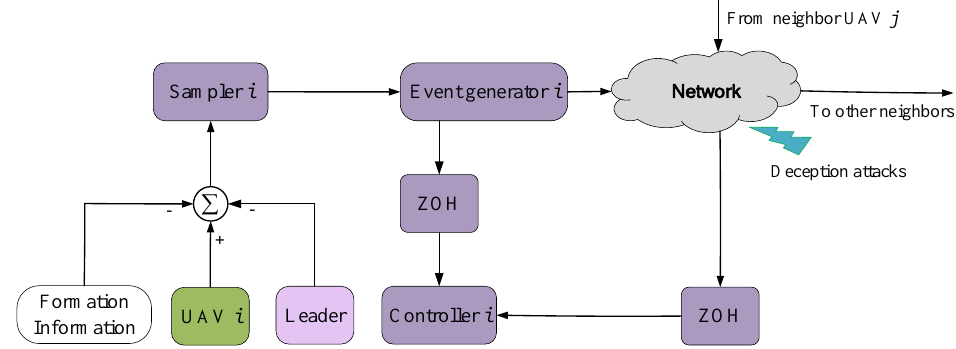
Figure 1. The framework of the overall formation control